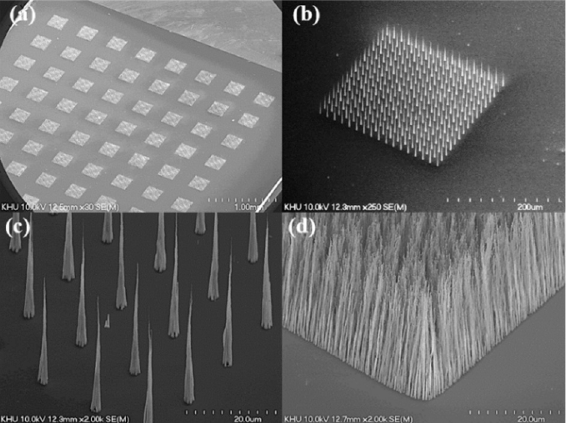
Figure 3. Scanning electron microscope (SEM) images of carbon nanotube (CNT) emitters grown by triode direct-current plasma-enhanced chemical vapor deposition (dc-PECVD). ( a ) Patterned CNT islands image; ( b ) magnified image of one island; ( c ) vertically aligned CNT emitters with cone shape in the island; ( d ) non-patterned CNT.